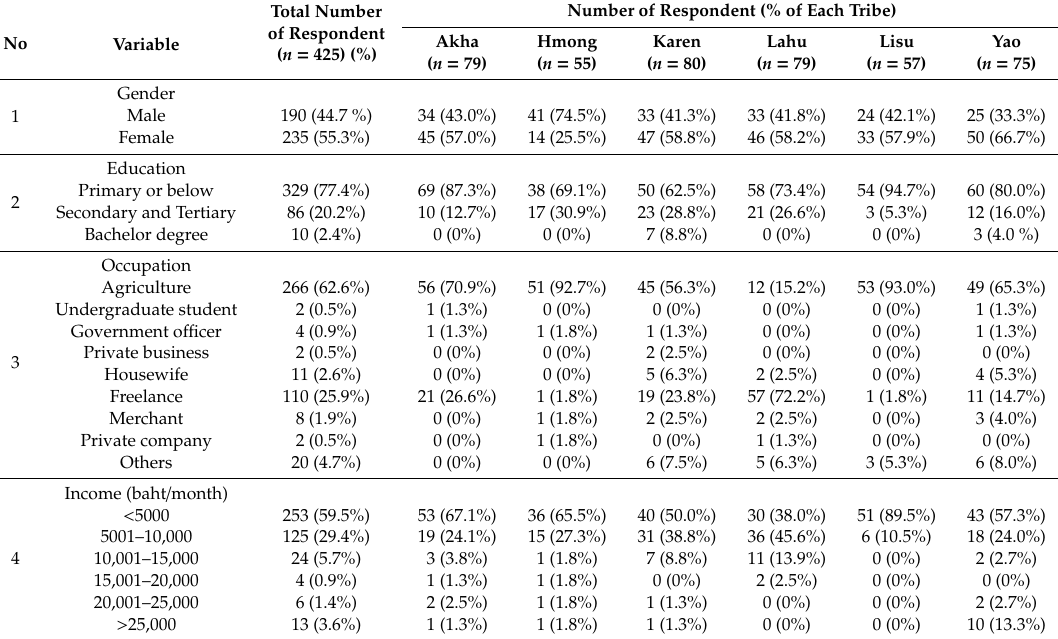
Table 1. Sociodemographic characteristics of respondent in six hill tribe